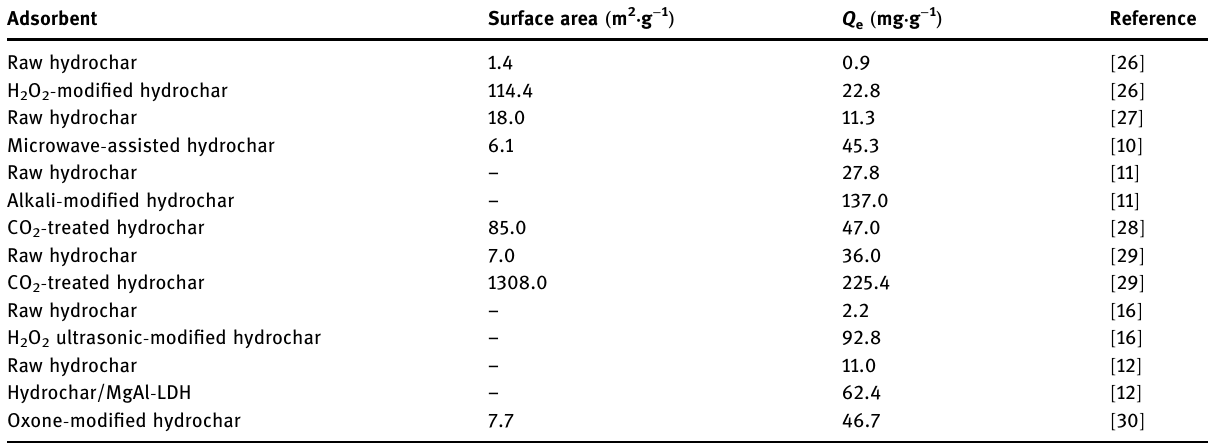
Table 2: Adsorption capacity of reported hydrochar for Pb 2 + in aqueous solutions Adsorbent